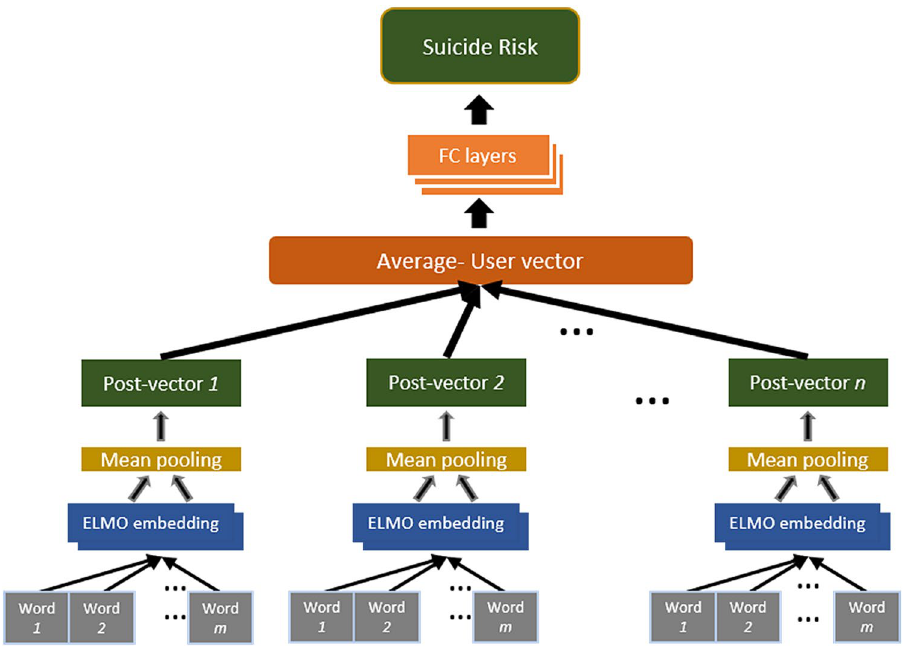
Figure 1. The single task model (STM). FC layers fully connected